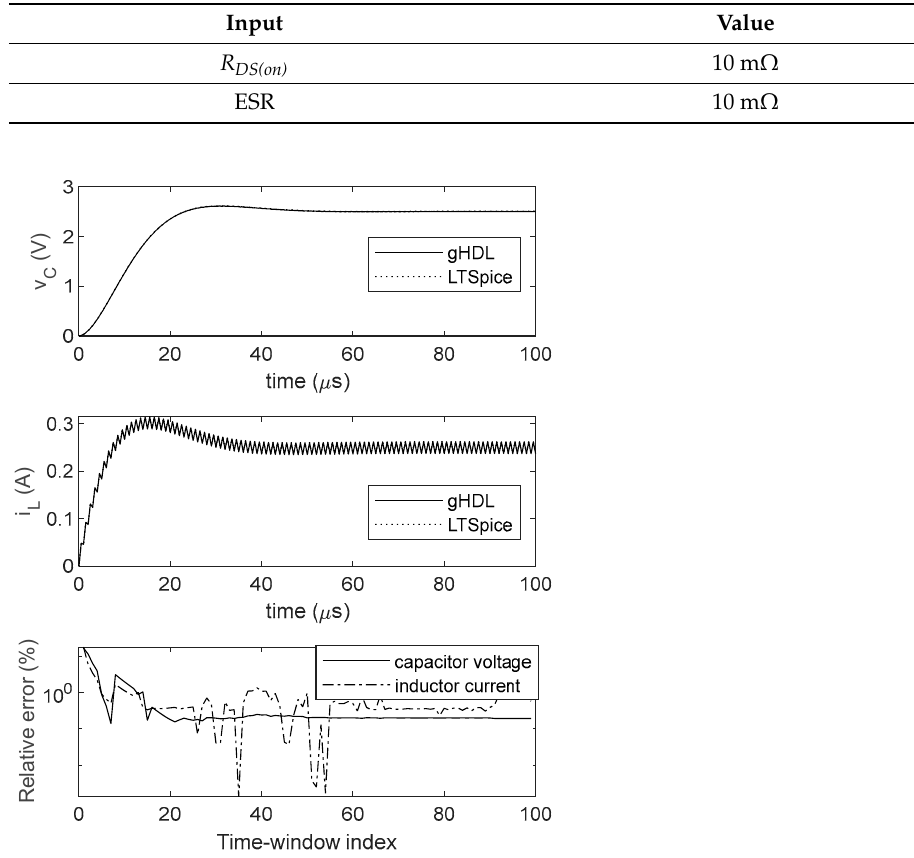
Figure 5. Synchronous step-down (buck) converter model with parasitic components and its wave- forms. The first and second plots are the capacitor voltage, respectively, and inductor current wave- forms obtained in gHDL and LTSPICE simulation. The relative error is drawn in the third plot.